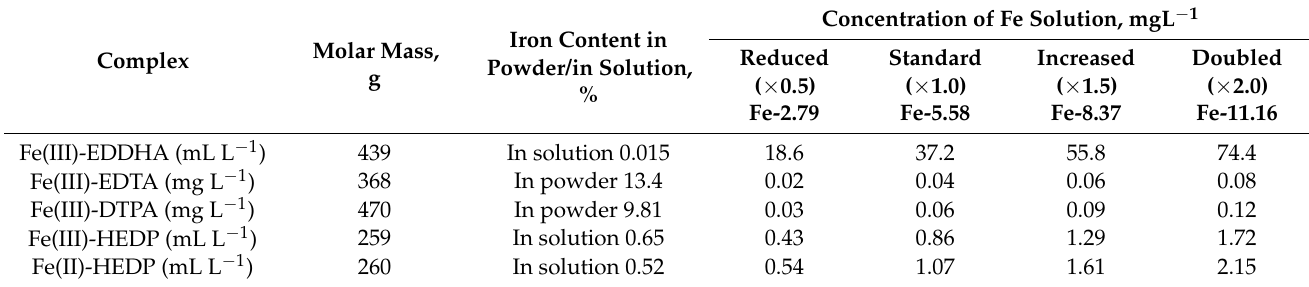
Table 1. Experimental concentrations of iron chelates in the modified nutrient